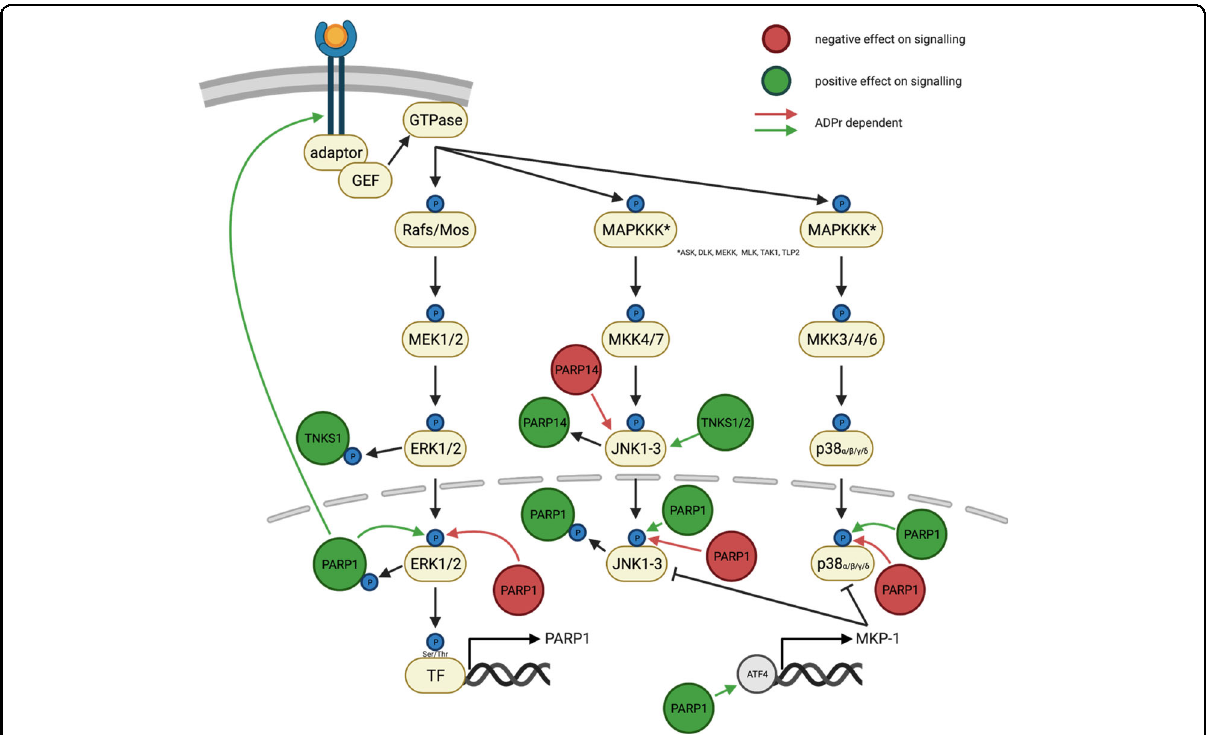
Fig. 4 Schematic overview of the interplay between MAPK signaling and ARTD family members. Positive regulations of MAPK signaling by ARTD family members are depicted in green, while negative effects of ARTDs on the signaling pathway are shown in red. Solid lines indicate the contribution of ADP-ribosylation to the regulation of MAPK signaling (TNKS1/2, Tankyrase1/2; Ser, Serine; Thr,